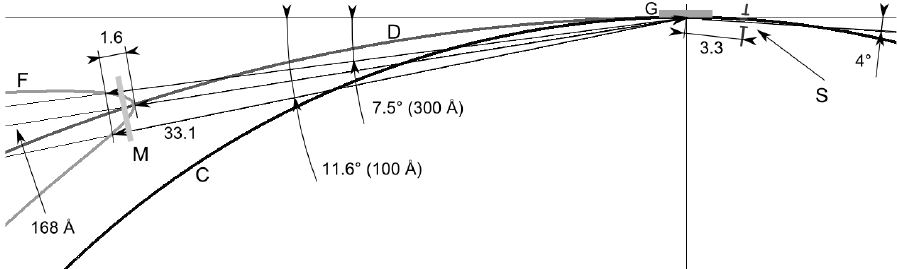
Fig. 2. The drawing of the proposed off-Rowland spectrometer with shifted slit. G – diffraction grating, R- Rowland circle, D – double Rowland circle, S – entrance slit, F – focusing curve, M – the entrance surface of the